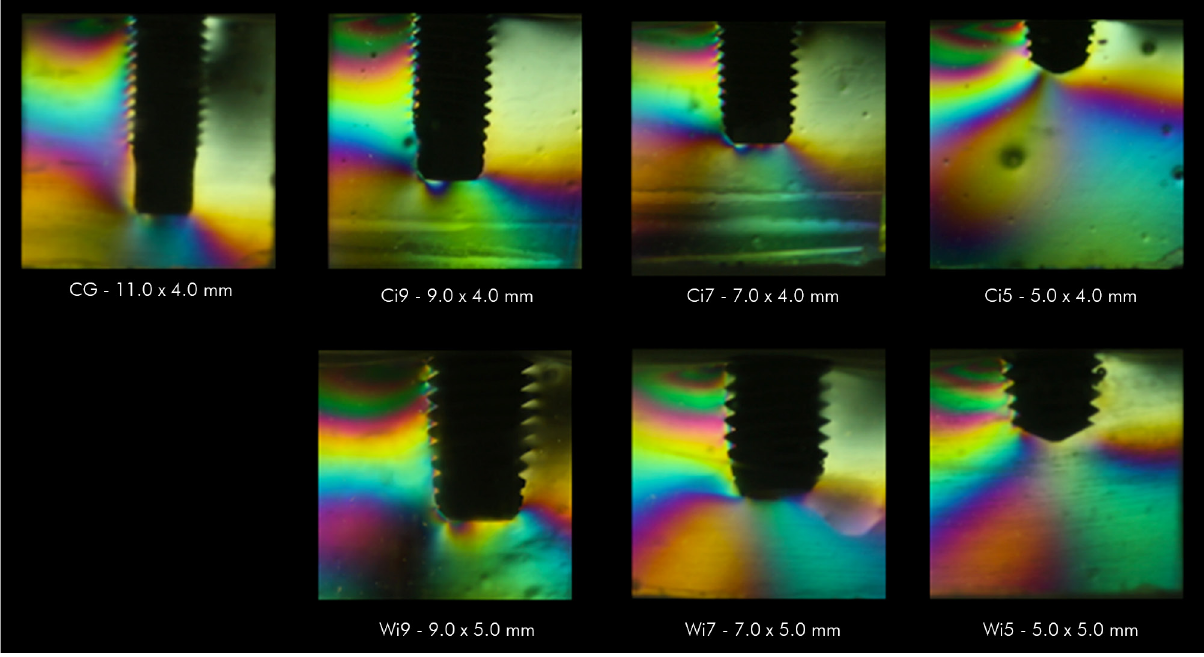
Figure 5. Illustration of the behaviour of fringes in the groups to implant A.